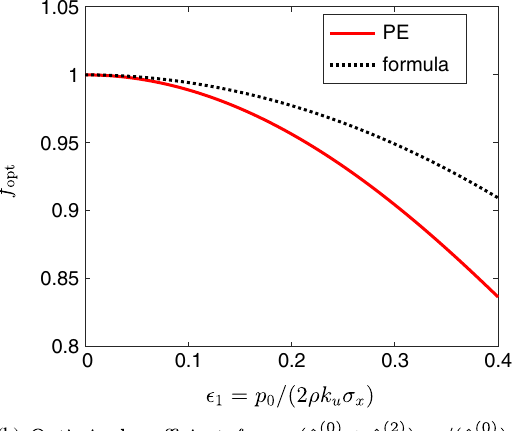
FIG. 4. Comparison between the scaled, local power growth − μ = ð 2 ρ k rate − ˆ μ and the results of the periodic analysis zi ¼ zi u Þ (PE). Also shown is the growth rate in the absence of a kick 30 m and ˆ ν ¼ − 0 . 5 , as in Figs. 1 – 3). (results for β ex ¼